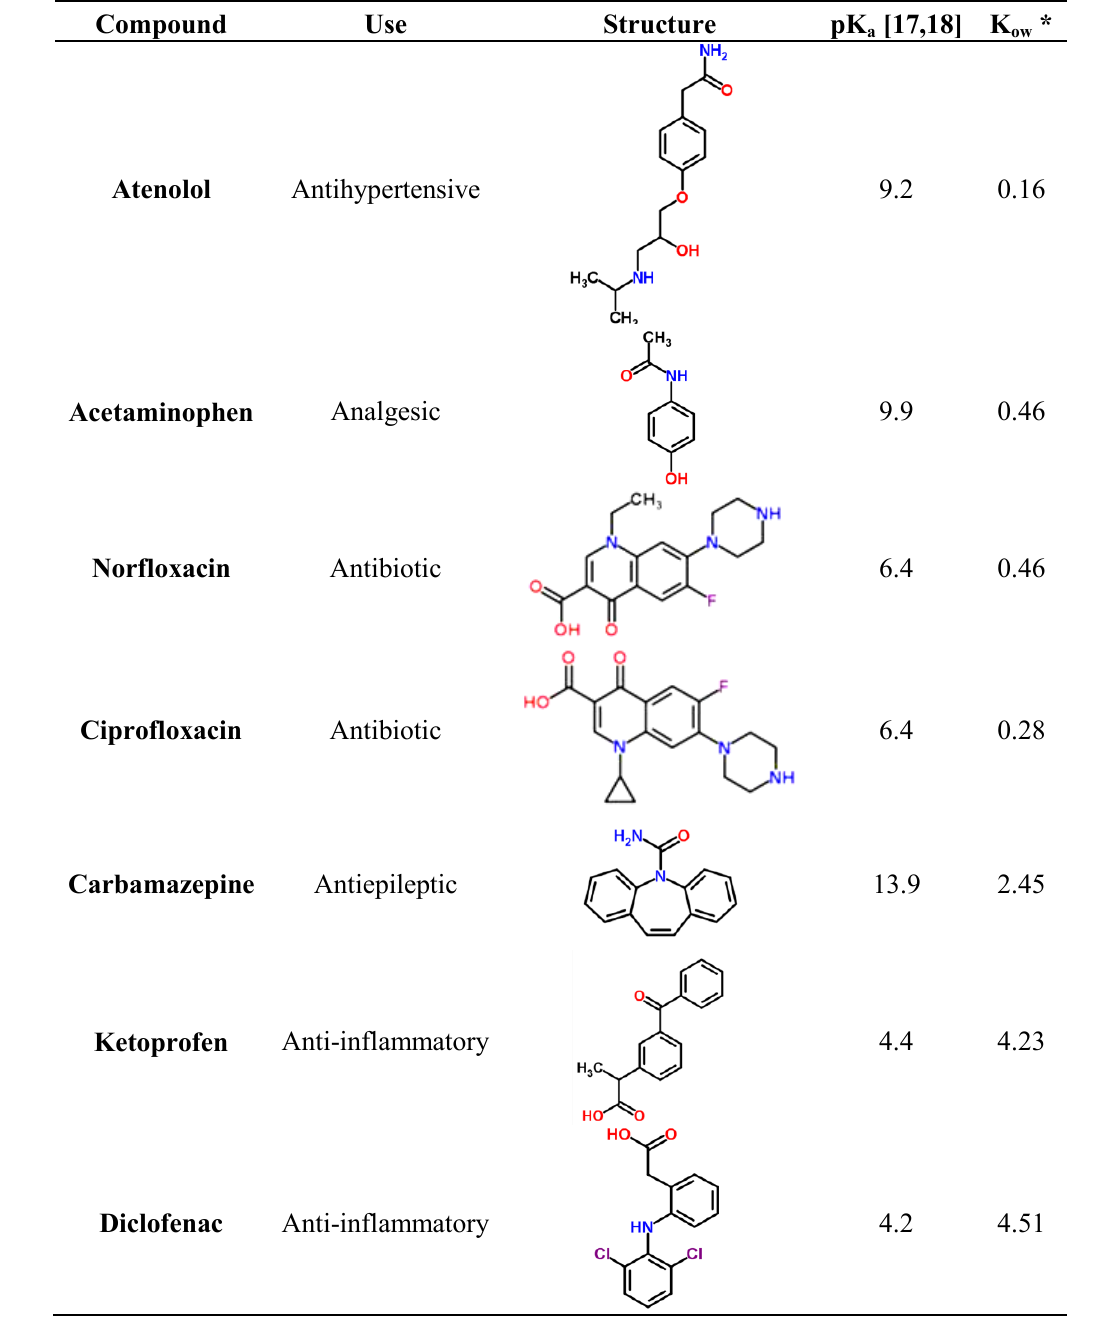
Table 1. List of pharmaceutical compounds, chemical structure and pKa